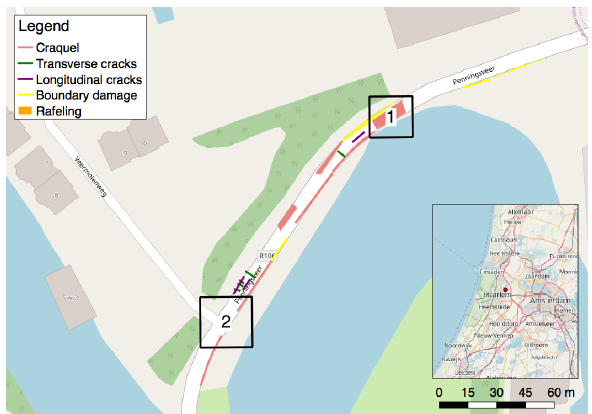
Figure 4. Part of the research area with locations of damages found by a road inspector. The black squares show the locations which are discussed in more